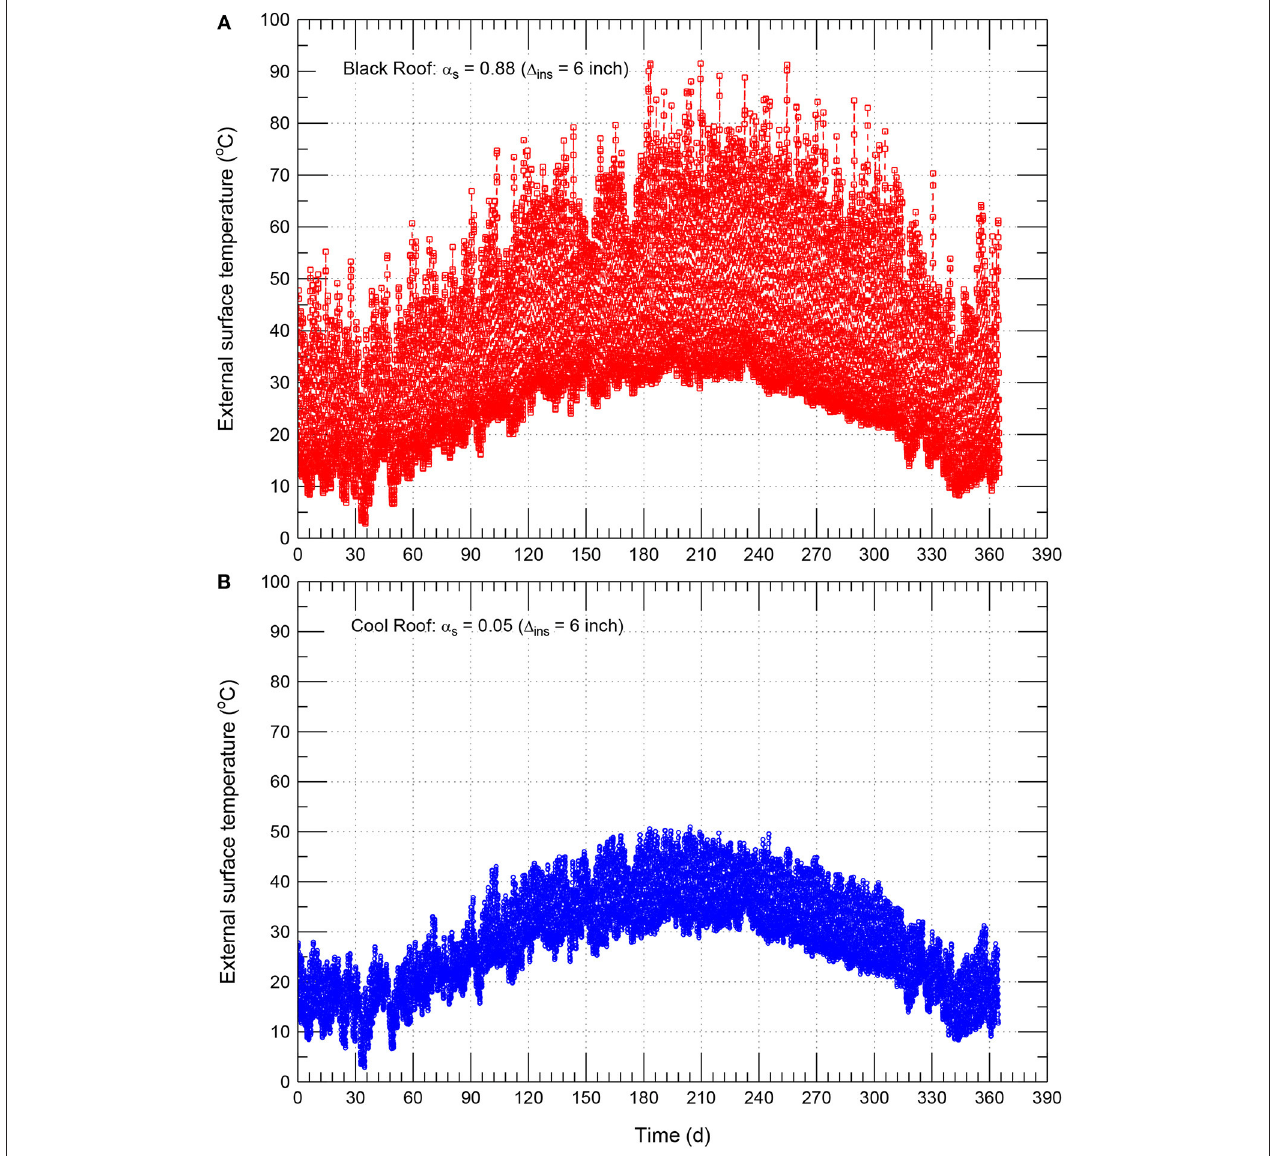
FIGURE 8 | Comparison of hourly external surface temperature of conventional/black roof ( α s = 0.88) (A) and cool roof ( α s = 0.05) (B) for 1 ins = 152mm (6.0 inch).